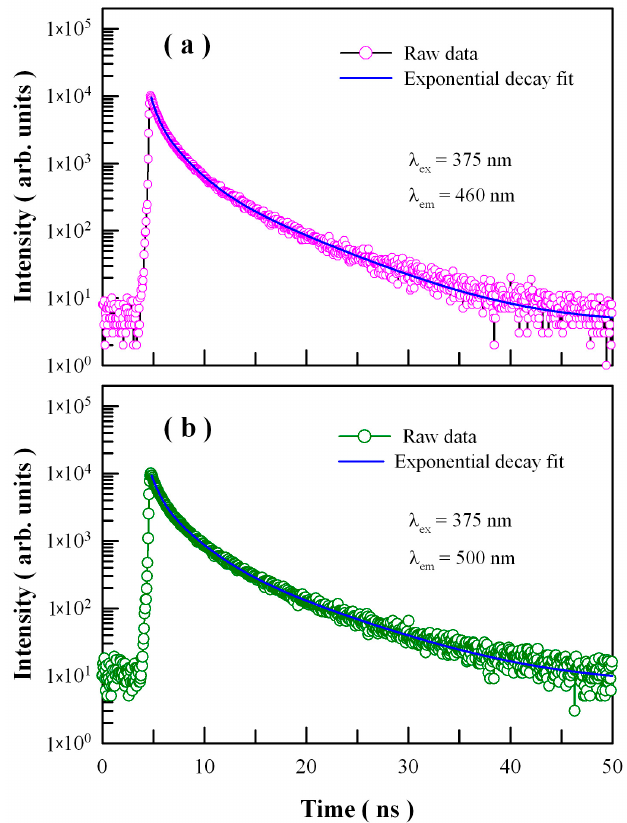
Figure 8. Time-resolved PL spectra for ZnWO 4 nanoplates at different detection wavelengths: ( a ) 460 nm; ( b ) 500 nm.